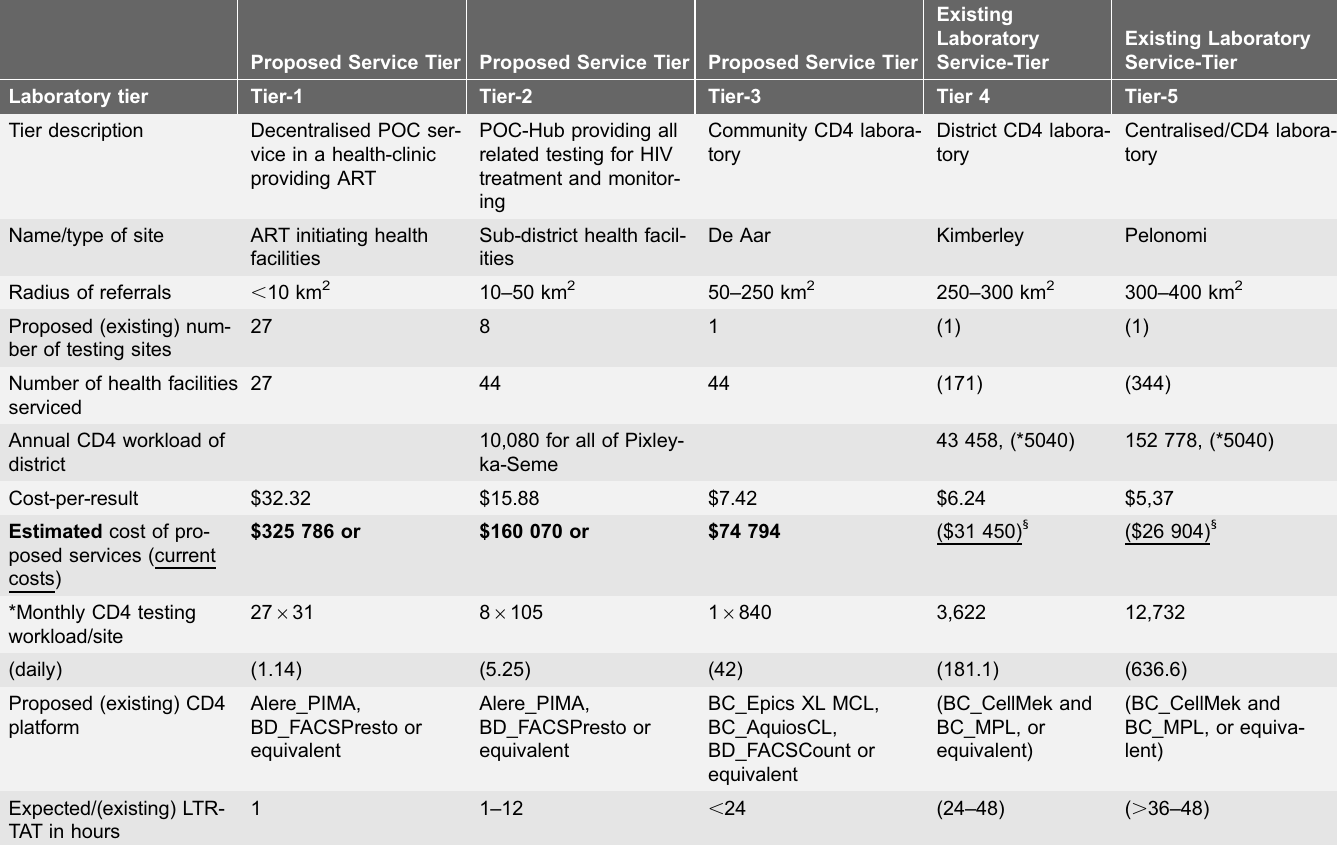
Table 1. CD4 tiers in